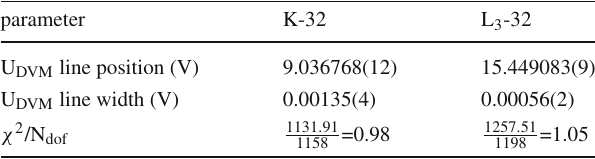
Table 1 Fit result for the combined analysis of the 40 innermost detec- tor pixels. For the denoted line, the work function difference ΔΦ between the source and the spectrometer is not known with sufficient precisionandisnotincluded.Thesameholdsforothersystematicuncer- tainties. We estimate the uncertainty of ΔΦ to be of the order of a few 100 meV. As ΔΦ drops out in the calculation of Δ U DVM , this does